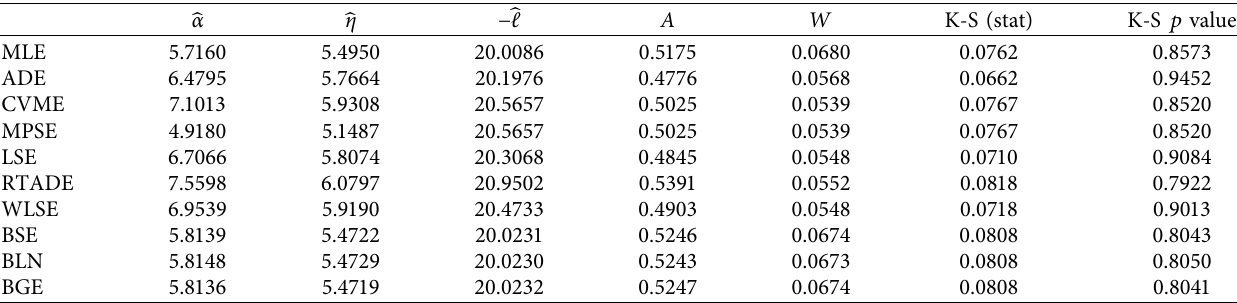
Figure 5: Histogram of dataset II with the fitted IPBH PDF, CDF, SF, and P-P plot. Table 8: The estimates of α , η , − 􏽢 ℓ , A , W , K-S (stat), and K-S p value of the IPBH distribution for dataset I.